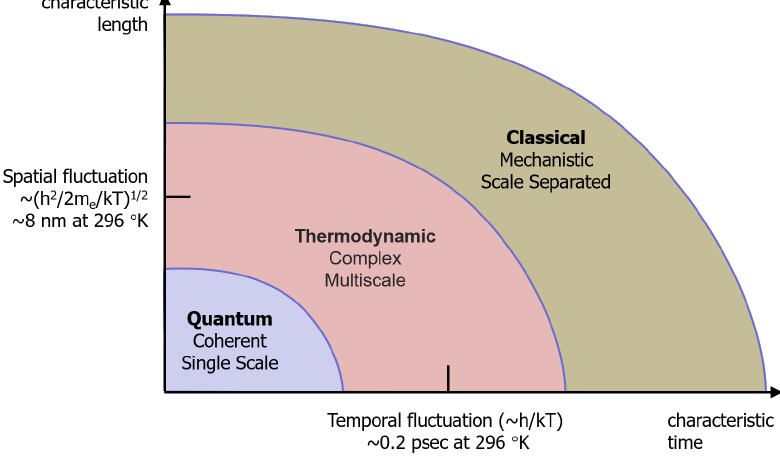
Figure 6. Three Major Domains of Computing by fluctuation